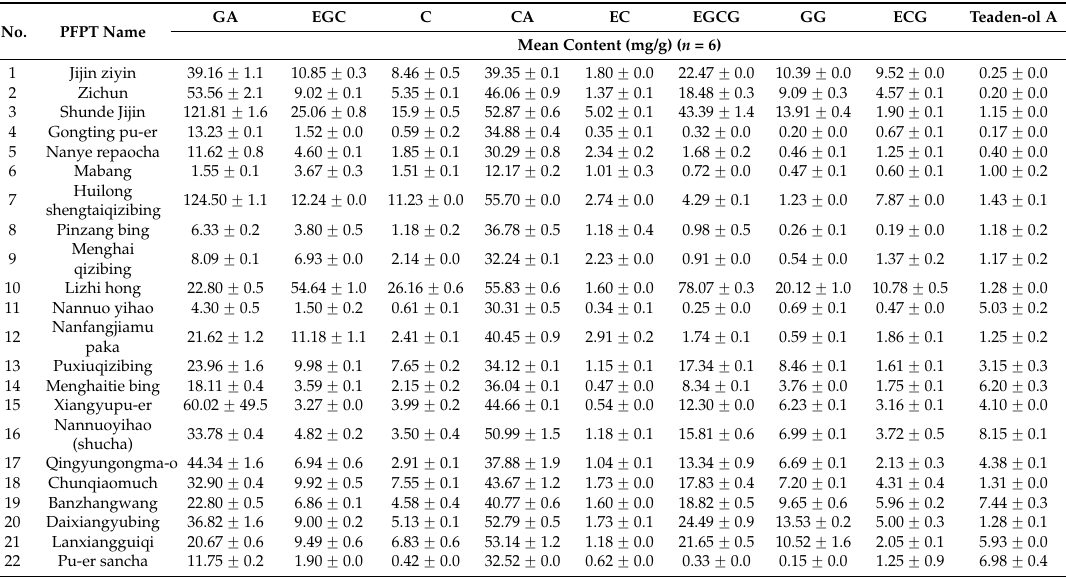
Table 1. Concentrations of gallic acid, catechins, caffeine, and Teadenol A in commercial post-fermented Pu-erh tea